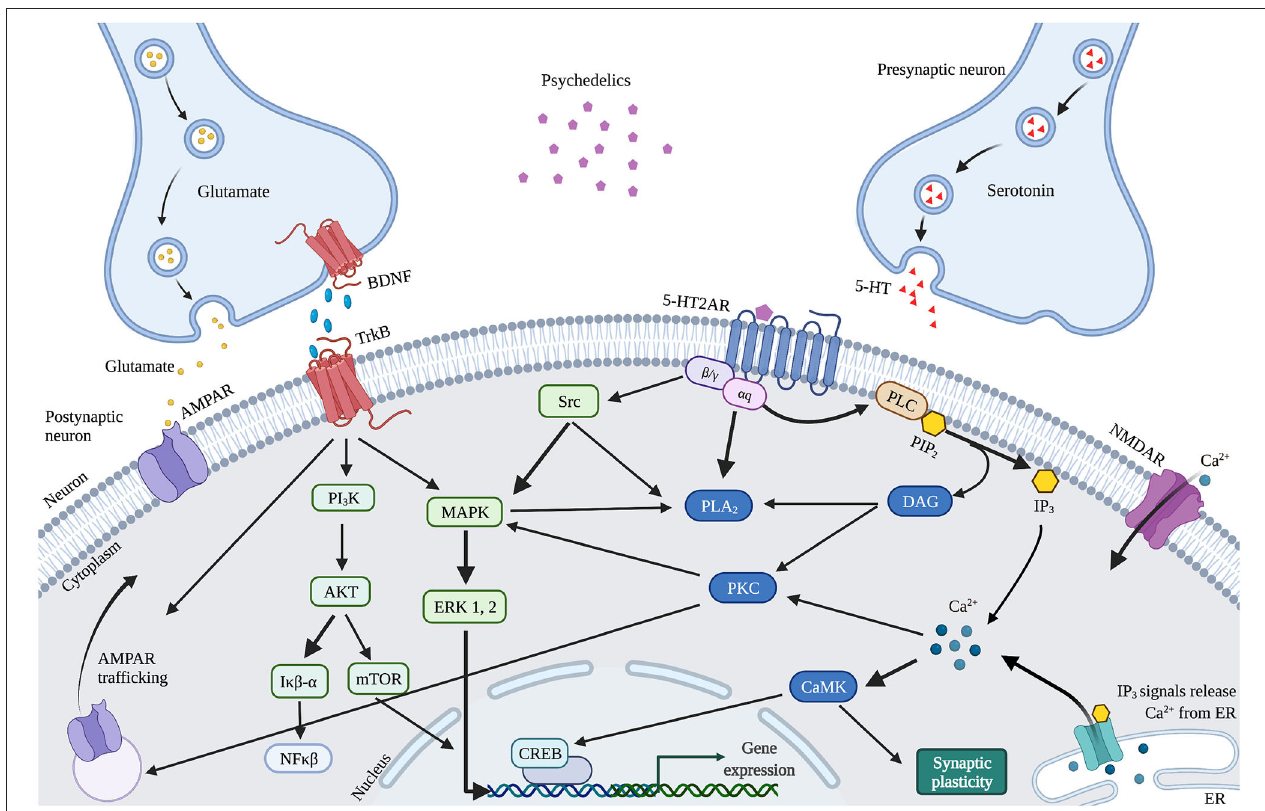
FIGURE 4 | Proposed mechanism of action of cellular and molecular effects of serotonergic psychedelics. Schematic and simplified overview of the intracellular transduction cascades in the PFC induced by 5-HT2AR activation by psychedelics. When activated by psychedelics, the 5-HT2AR can activate multiple signaling cascades by coupling to G-proteins. These can activate PLC or PLA 2 signaling, both leading to modulations in synaptic plasticity. In addition, glutamate and TrkB activation stimulate AMPAR trafficking. BDNF also activates mTOR through TrkB, resulting in stimulated synaptic plasticity. 5-HT, Serotonin; 5-HT2AR, Serotonergic 2A receptor; Akt, Protein kinase B; AMPAR, α -amino-3-hydroxy-5-methyl-4-isozalopropionic acid receptor; BDNF, Brain-derived neurotropic factor; C/EBP- β , CCAAT enhancer binding protein; CAMK2, Ca 2 + /calmodulin-dependent protein kinase; CREB, cyclic AMP-responsive element-binding protein; DAG, Diaglycerol; ERK 1/2, extracellular regulated kinase 1/2; I κβ - α , inhibitor of nuclear factor kappa B alpha; IP 3 , Inositol triphosphate; MAPK, mitogen-activated protein kinase; mTOR, Mammalian target of rapamycin; NF κβ - α , nuclear factor kappa B protein complex alpha; NMDAR, N-methyl-D-asparate receptor; PI 3 K, Phosphatidylinositol-4, 5-bisphosphate 3-kinase; PKA, Protein Kinase A; PLA 2 , Phospholipase A 2 ; PLC, Phospholipase C; TrkB, Tropomyosin receptor kinase